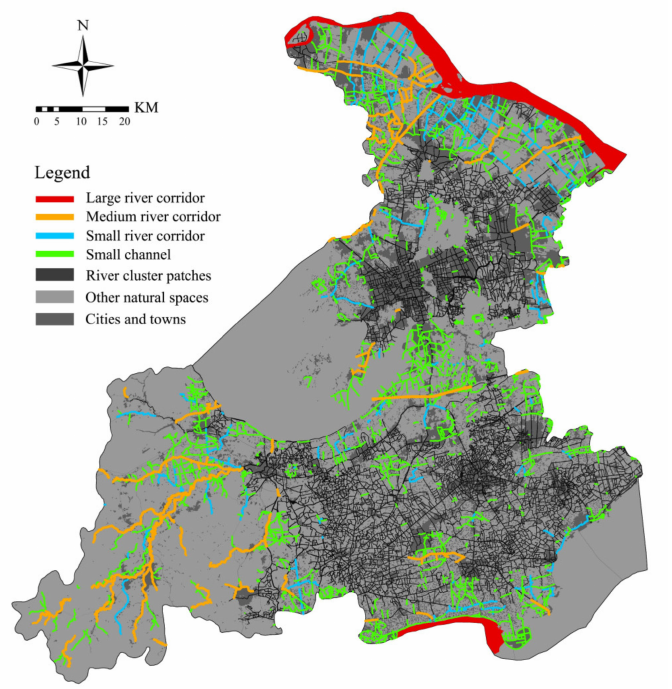
Figure 4. Identification and multi-level division of river corridors in the Hu-Su-Jia